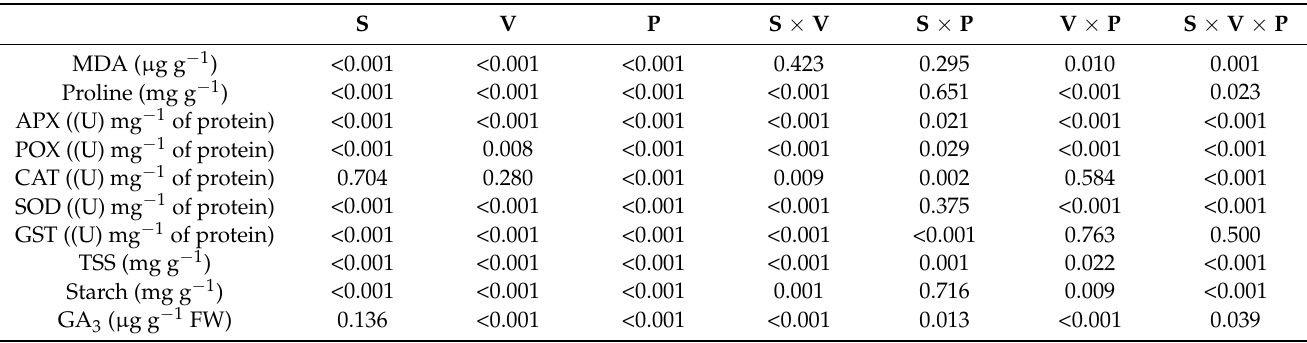
Table 2. Significance of site (S), variety (V), phenological stage (P) and interaction effects (S × V; S × P; V × P; S × V × P) on MDA, proline, antioxidant enzymatic activity (APX, POX, CAT, SOD, GST), nonstructural carbohydrates (TSS and starch), and GA 3 , according to repeated-measures ANOVA. The values are significantly different at p < 0.05 by Tukey’s HSD